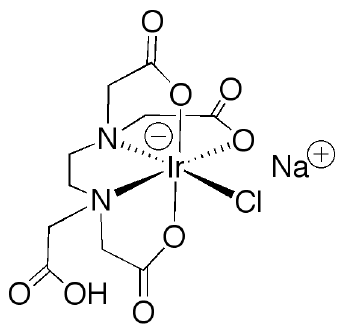
Figure 1. Molecular structure of [Ir(HEDTA)Cl]Na complex.